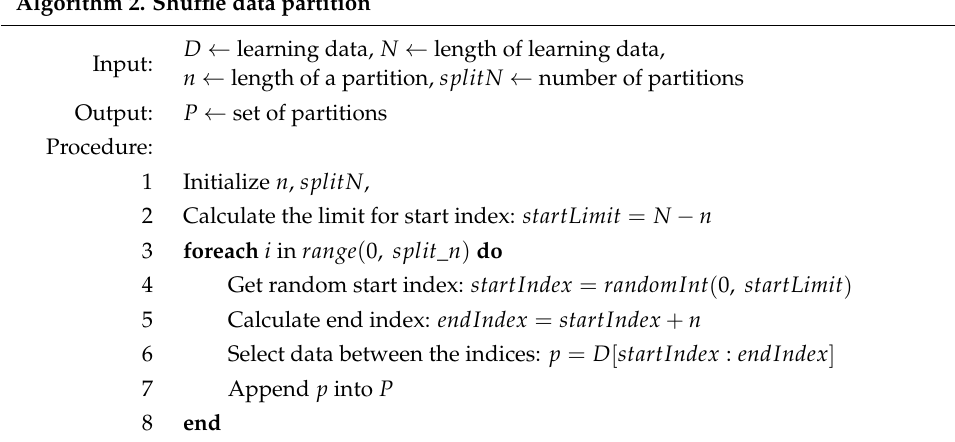
Algorithm 2. Shuffle data